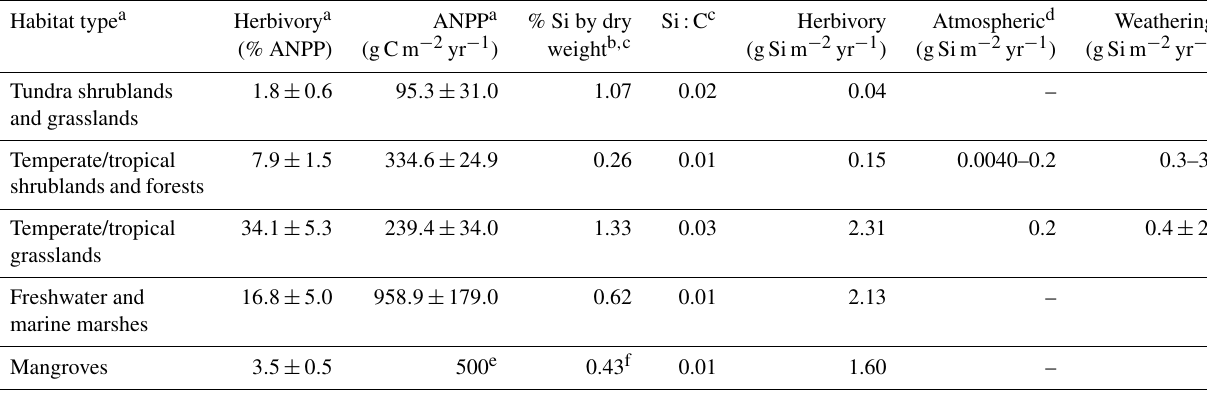
Table 1. Estimated Si fluxes by atmosphere, mineral weathering and herbivory by major terrestrial habitat type. ANPP is aboveground net primary